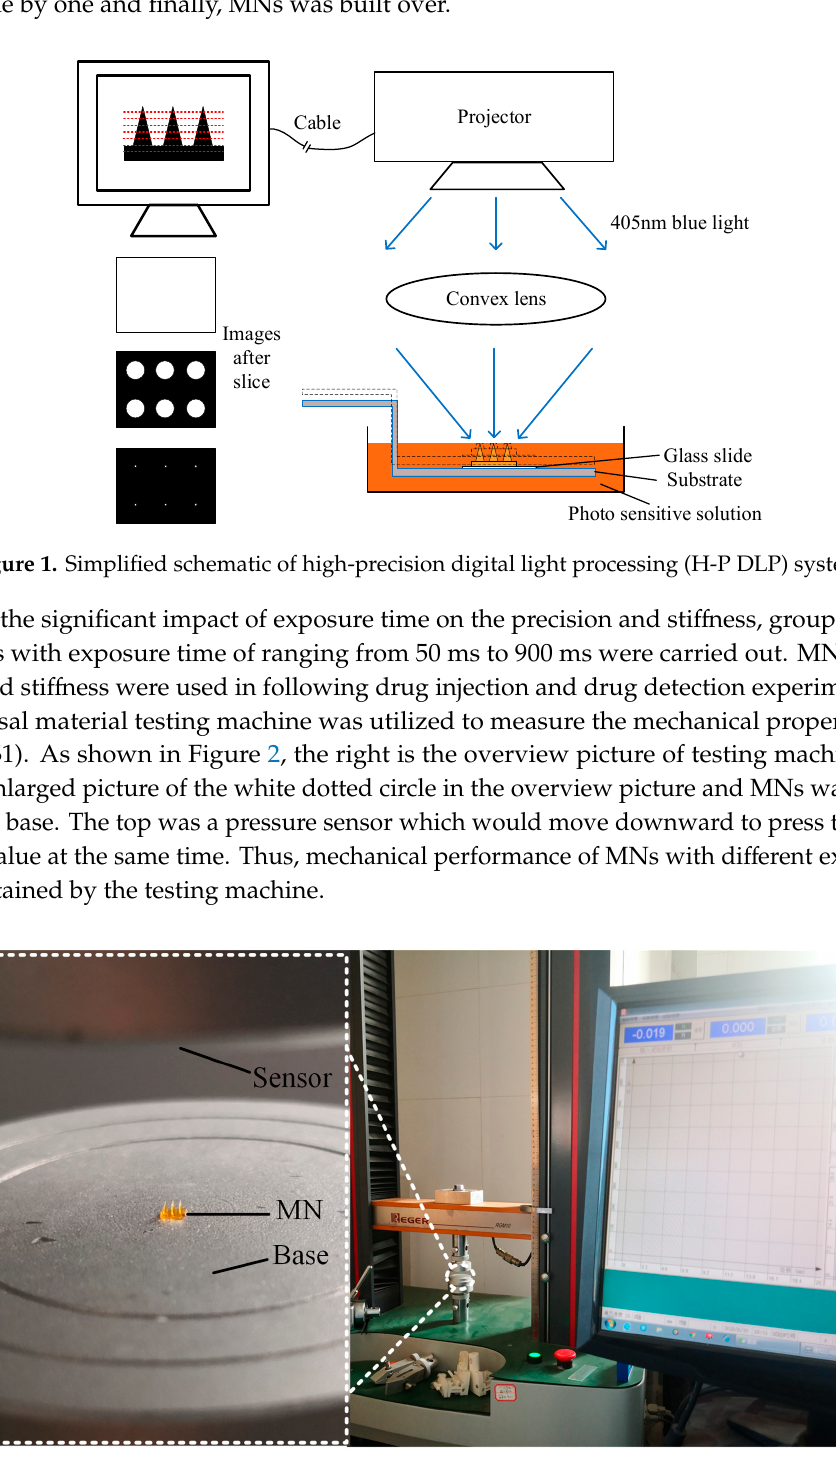
Figure 2. Measuring the mechanical performance of microneedles (MNs) with universal material testing machine.